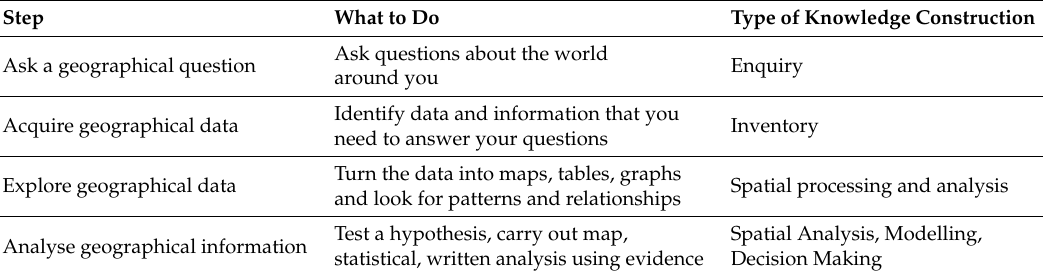
Table 1. Steps in Enquiry in GIS (After ESRI